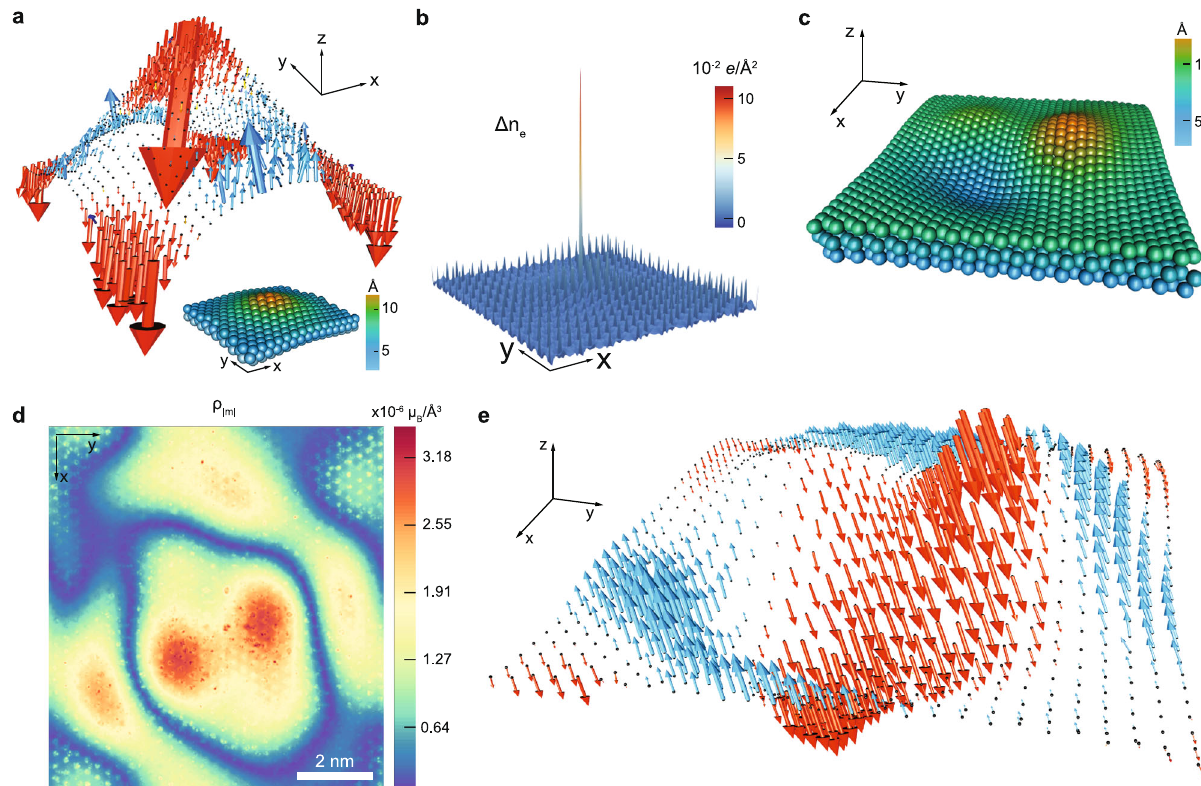
Fig. 5 | Curvature-induced magnetism in monolayer MoS 2 . a DFT-calculation of local magnetic moments in a spherical curvature structure of doped MoS 2 (+4 e /unit-cell). The surface of the structureisindicated by dots with the magni fi ed z -axis for better visualization. Inset at the bottom is the atomic structure (4.74×4.38nm 2 ). b The calculated electron-doping charge density ( Δρ e ) in